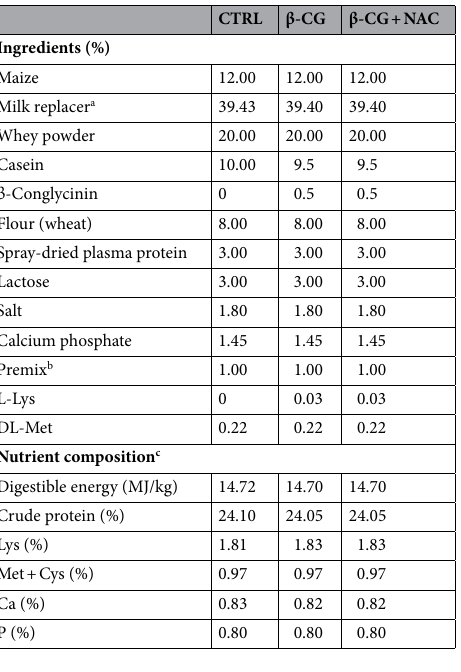
Table 1. Ingredient composition and nutrient levels of milk replacer powder diets (as-fed basis). a Milk replacer contained hydrolyzed wheat protein rather than soybean protein. b Premix provided the following vitamins and trace minerals per kilogram of milk replacer powder diet: Fe, 100 mg; Cu, 20 mg; Mn, 40 mg; Zn, 100 mg; I, 0.4 mg; Se, 0.3 mg; retinol acetate, 3.6 mg; cholecalciferol , 0.05 mg; DL-α-tocopheryl acetate, 30 mg; Menadione , 3 mg; thiamin , 2 mg; riboflavin , 6 mg; pyridoxine , 7 mg; Cyanocobalamin , 0.04 mg; biotin, 0.1 mg; Folic acid, 2 mg; niacin, 40 mg; D-calcium pantothenate, 20 mg. c Analyzed